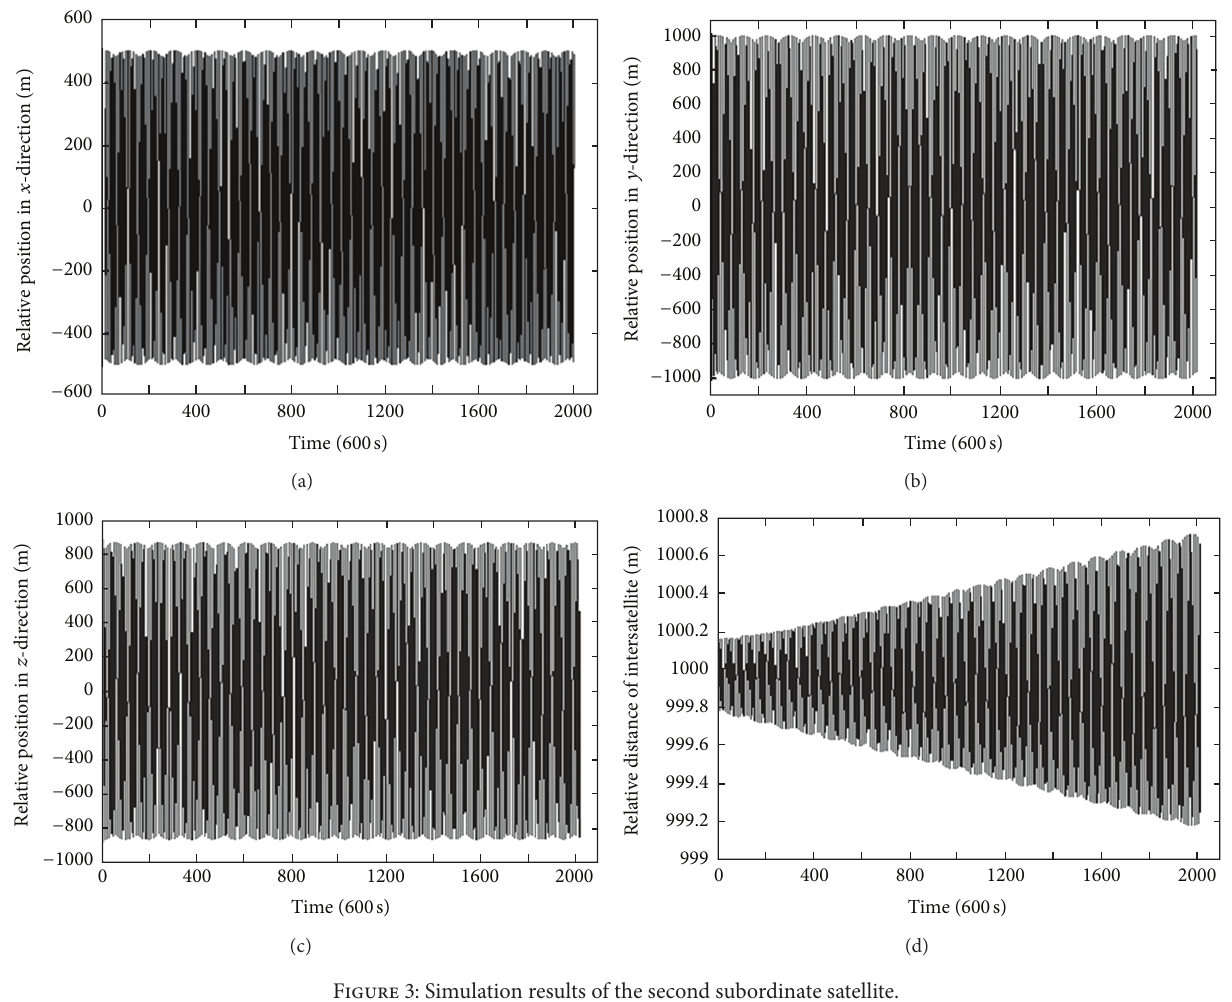
Figure 3: Simulation results of the second subordinate satellite.